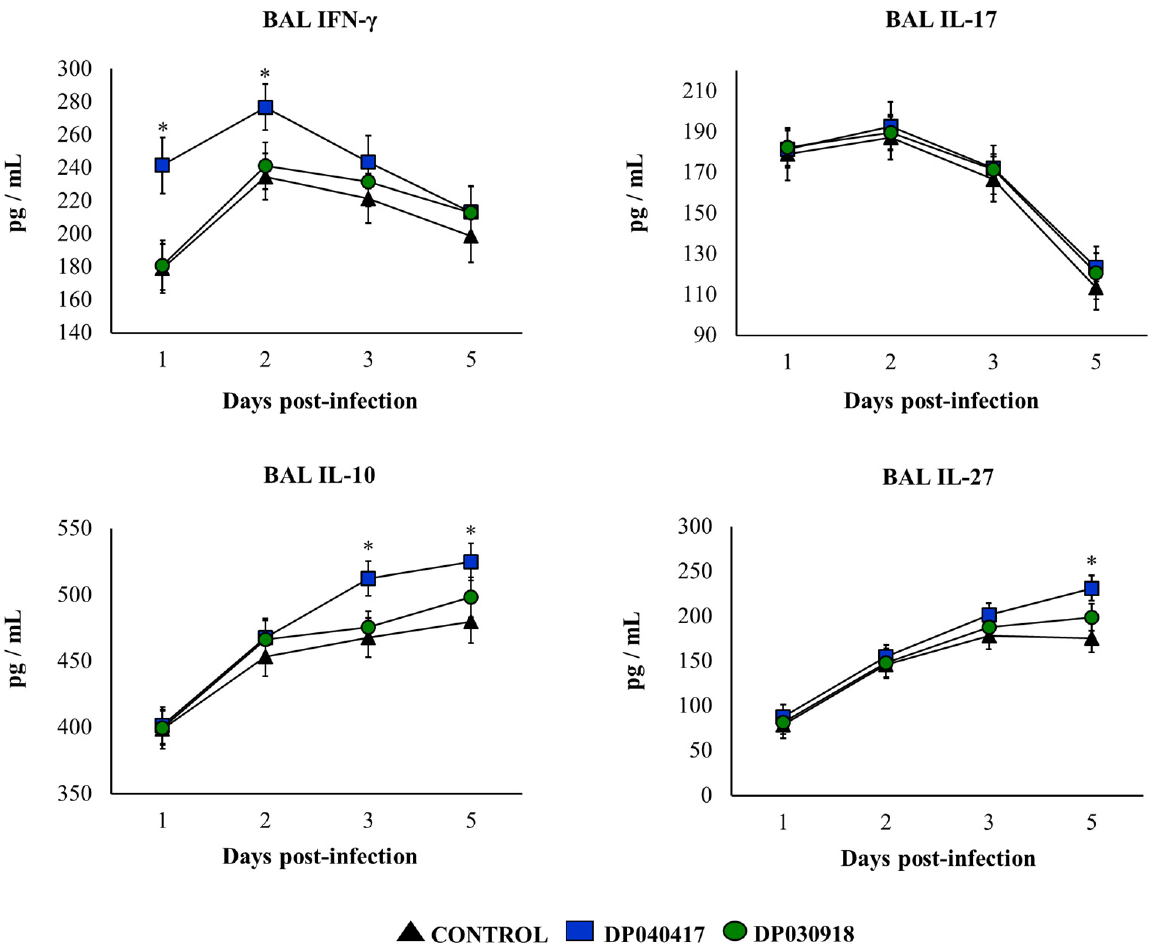
Figure 5. Effect of the respiratory commensal bacteria Dolosigranulum pigrum on resistance to Streptococcus pneumoniae infection. Infant mice were nasally primed with viable D. pigrum (DP) strain 040417 or 030918 during five consecutive days at a dose of 10 8 bacterial cells/mouse/day. One day after the last administration of DP strains, mice were challenged with S. pneumoniae serotype 3. Non-treated infant mice challenged with S. pneumoniae were used as controls. Interferon (IFN)- γ , interleukin (IL)-17, IL-10, and IL-27 concentrations in broncho-alveolar lavages (BAL) were evaluated on different time points after the bacterial challenge. The results represent data from three independent experiments ( n = 6 per each group at each time point). Significantly different when compared with control at the same time point, * p < 0.05.